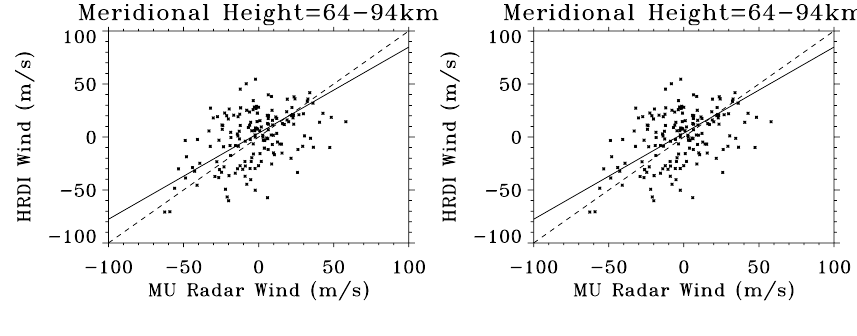
Fig. 7. Scatter diagram of the wind ve- locity observed with UARS/HRDI ( y - axis) and the MU radar ( x -axis). The solid line is the best fit line. The MU radar wind was estimated with a 15 minute